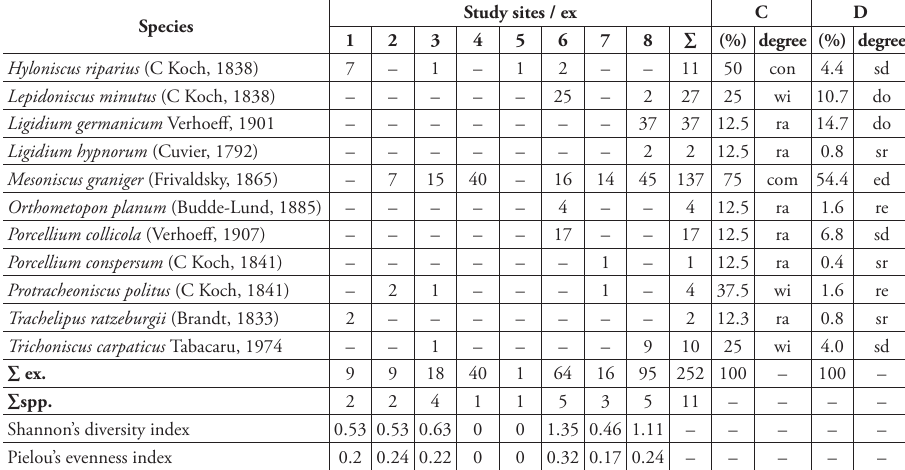
Table 2. List of sampled isopod species and community characteristics . Abbreviations: C-Constan- cy: com-common, con-constant, wi-widespread, ra-rare; D-Dominance: ed-eudominant, do-dominant, sd-subdominant, re-recedent, sr-subrecedent. The numbers indicating particular studied scree slopes are stated in Figure